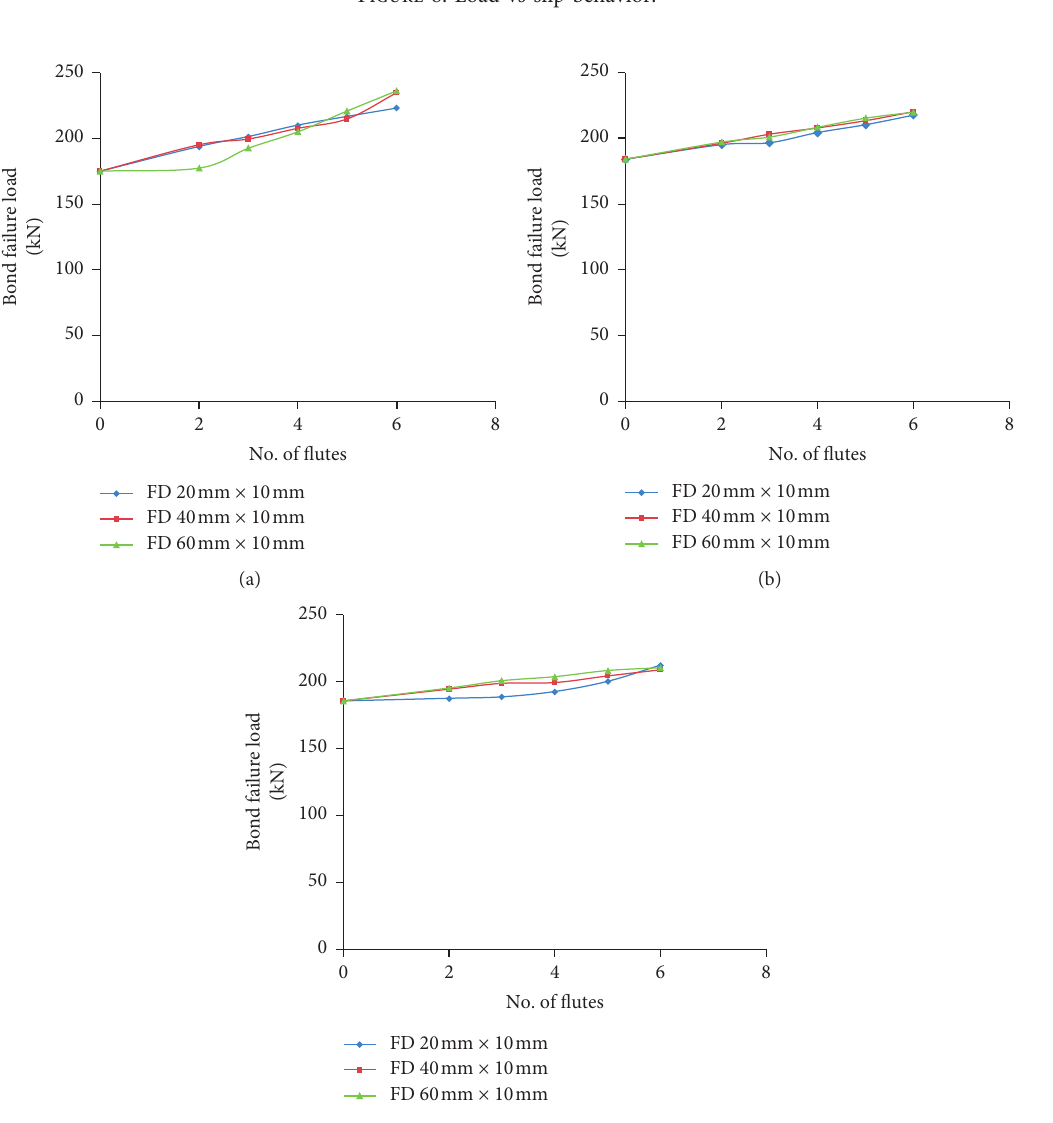
Figure 8: Load vs slip